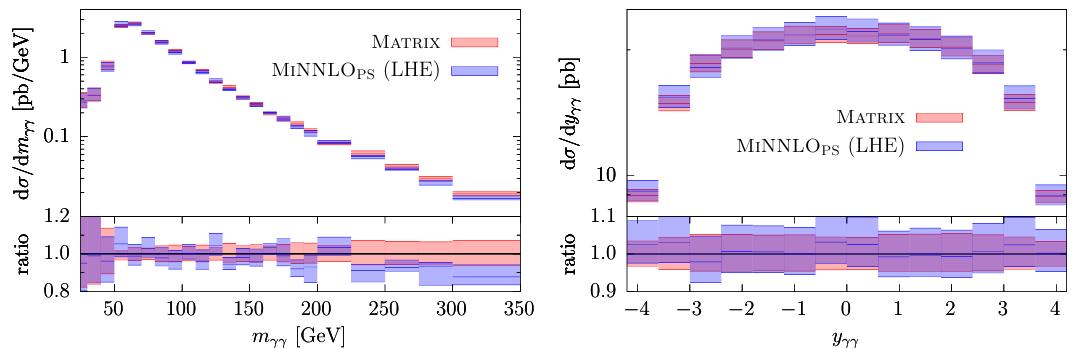
Figure 5 . Comparison between the distributions obtained from the fixed-order calculation from Matrix and the results after the generation of the hardest emission, for the diphoton invariant mass and